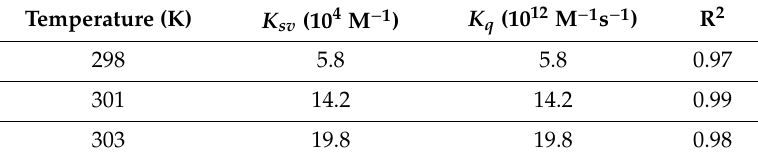
Figure 6. ( A ) Stern-Volmer plots, ( B ) Modified Stern-Volmer plots, and ( C ) van ’t Ho ff plots of CDK6-EA Figure 6. (A) Stern – Volmer plots, (B) Modified Stern – Volmer plots, and (C) van ’t Hoff plots of CDK6 - interaction at three temperatures (298 K, 301 K, and 303 K). EA interaction at three temperatures (298 K, 301 K, and 303 K). Table 1. Thermodynamic parameters of CDK6-EA obtained through a Stern-Volmer plot. Temperature